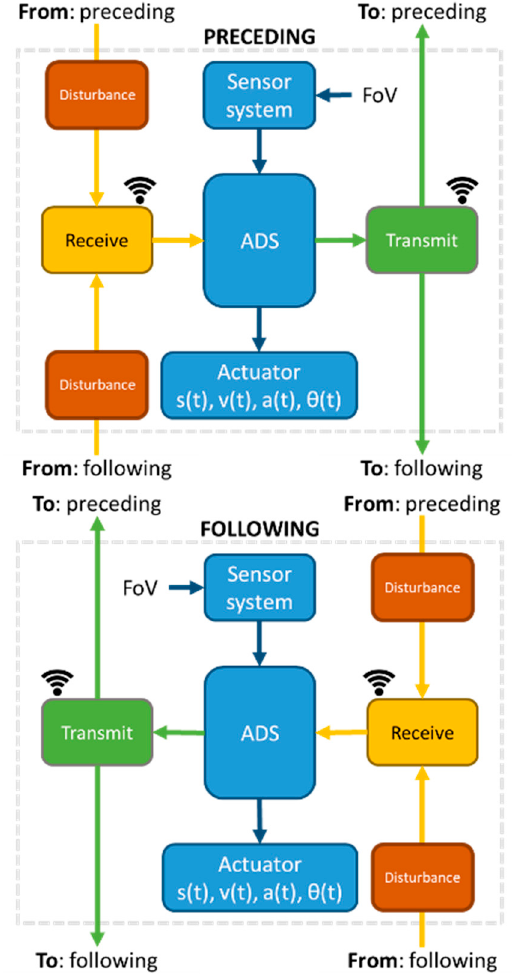
Figure 2. Input-output scheme [19] for two communicating vehicles in a platoon where ADS is the automated driving system and FoV is the field of view of the sensor system onboard each vehicle. The figure shows the situation without I2V communication.